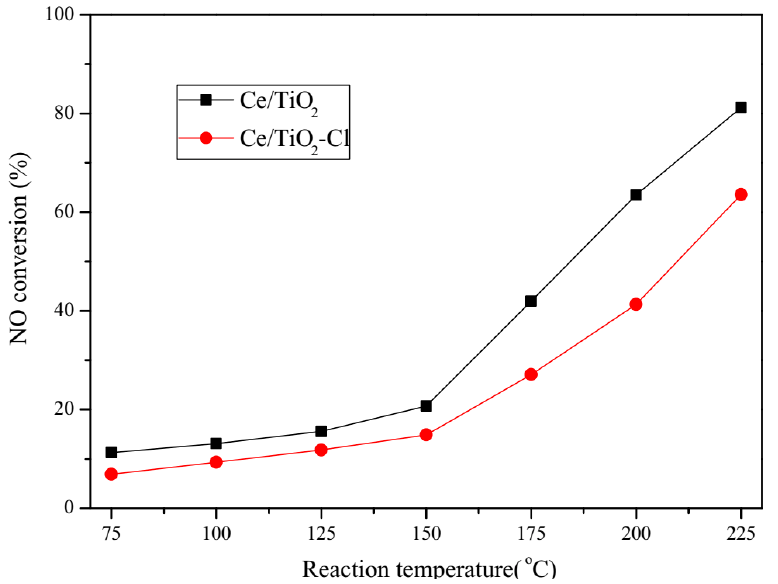
Figure 21. The SCR activities of Ce/TiO 2 and Ce/TiO 2 -Cl as a function of reaction temperature Reaction conditions: [NO] = [NH 3 ] = 600 ppm, [O 2 ] = 5%, balance Ar, GHSV = 108,000 h − 1 [89].